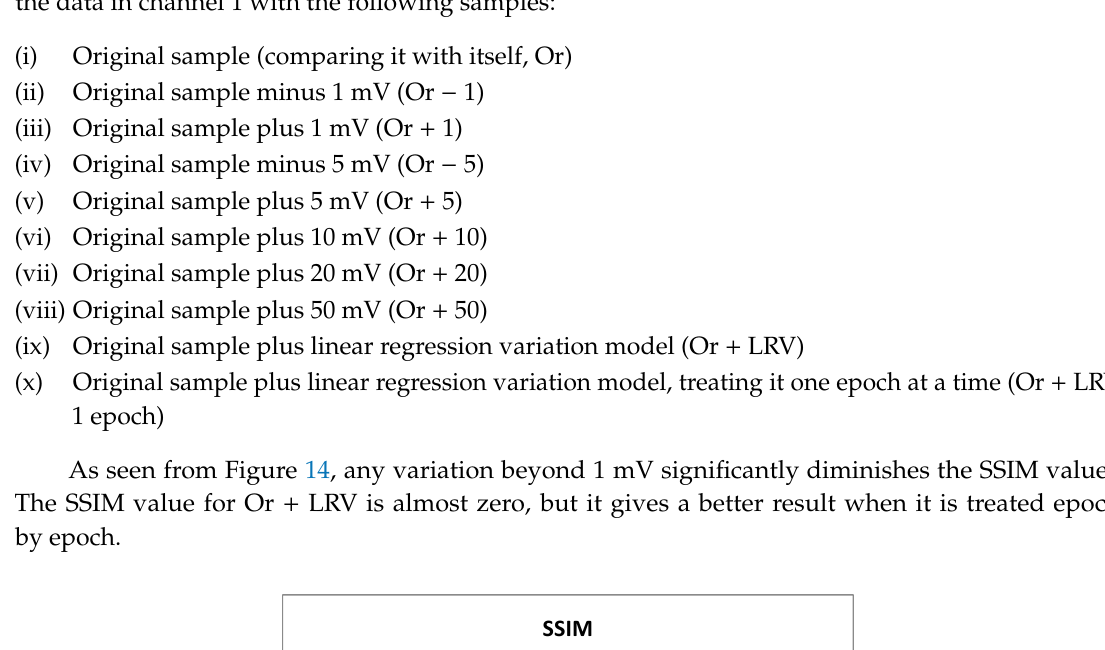
Figure 15. The effect of variation on CW-SSIM. The CW-SSIM calculation in the BeCoS approach is similar to the LRV − based model, which explains why the values are lower than the CW-SSIM values for the BSBL-BO approach even though